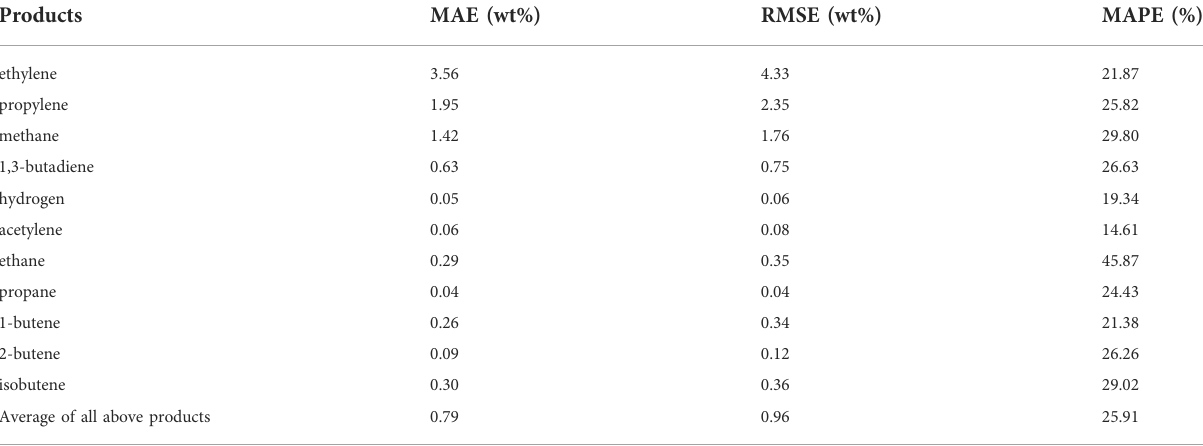
TABLE 6 Statistics for 11 predicted products with the compared